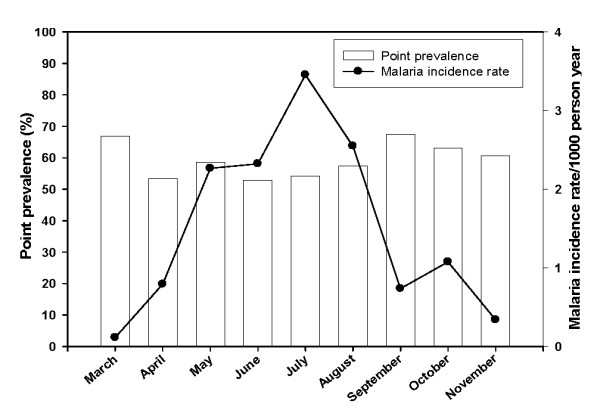
The monthly point prevalence of asymptomatic malaria parasitaemia and incident rate of clinical malaria. The point prevalence of asymptomatic parasitaemia for each month is represented as a bar graph and the pattern of clinical malaria (incident rate) is shown as a line graph.